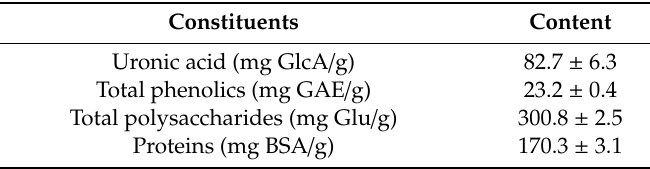
Table 1. Chemical characterization of CBSE used for SeNPs synthesis ( n = 3, mean ± SD).